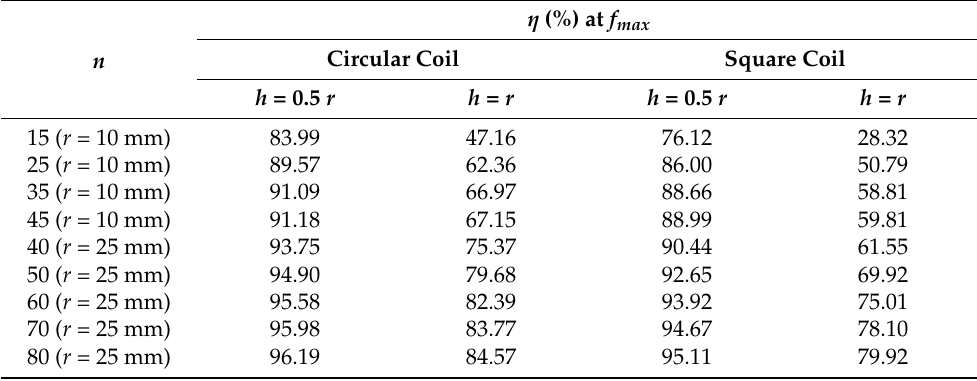
Table 9. Values of absolute error calculated for power transfer efficiency at all frequencies and cases.